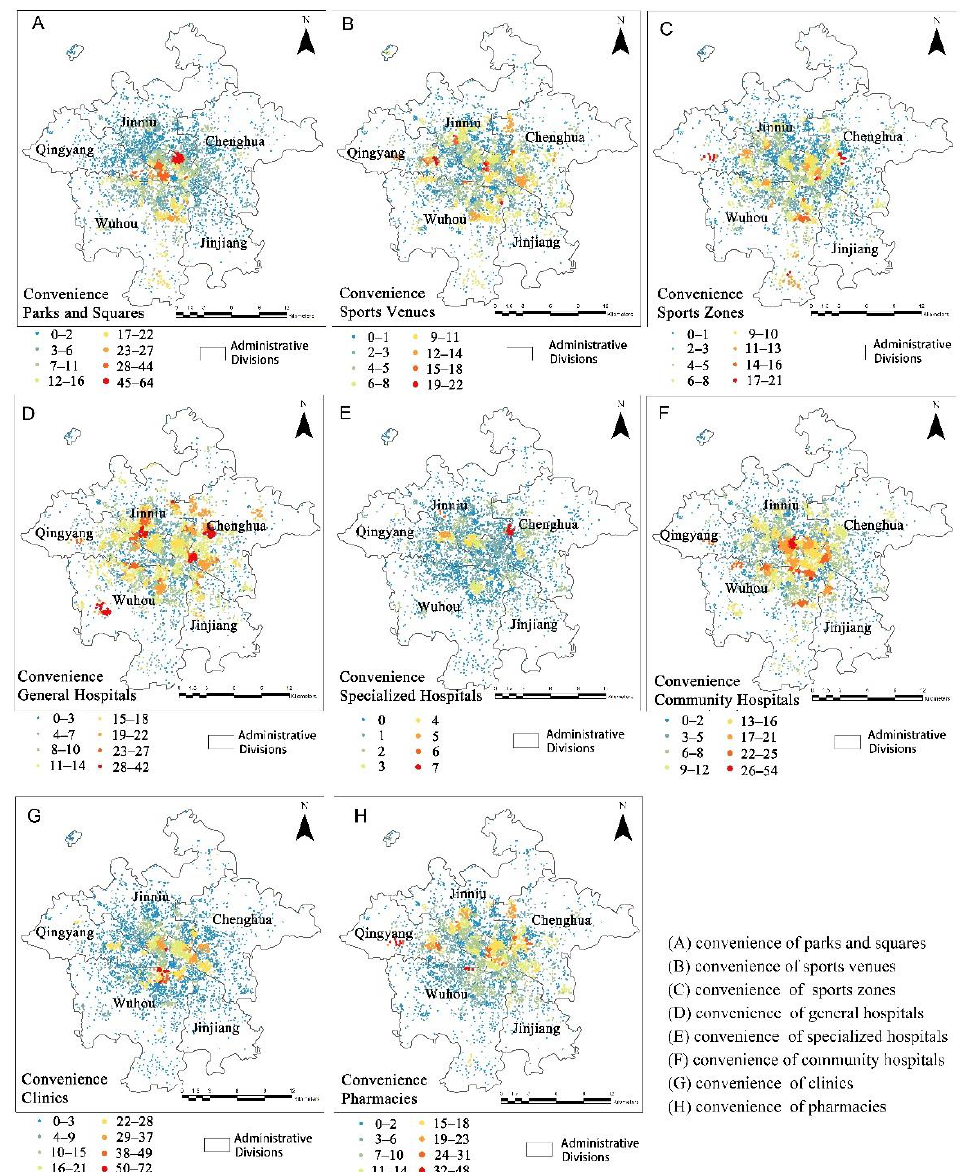
Figure 5. The degree of convenience in accessing various facilities.